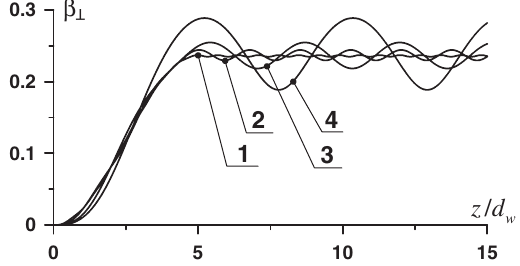
FIG. 3. Trajectory of electrons (cid:2) ? ð z Þ in the wiggler with up- tapered entrance for different guide field strength f :